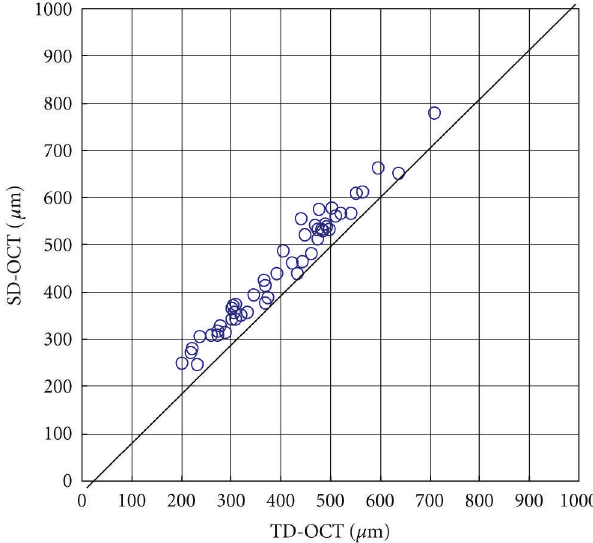
Figure 3: The di ff erence between TD-OCT and SD-OCT average retinal thicknesses in patients with DME in a central 1 mm area is about 45 µ m. These two data sets are well correlated (correlation coe ffi cient, 0.977, P < 0 . 001, Pearson’s product moment correla- tion).